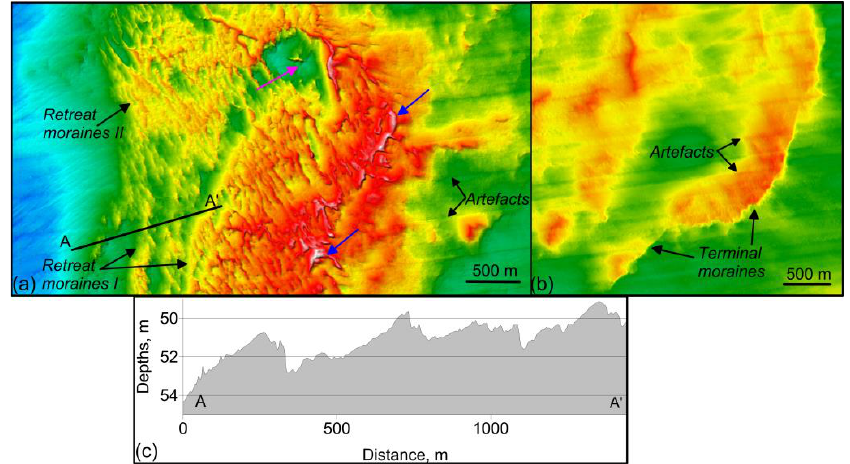
Figure 3. ( a ) Detailed map of the glacial landforms mapped in the north-western part of Area 1; ( b ) Detailed map of the glacial landforms mapped in the south-eastern part of Area 1 (the locations are in Figure 2); ( c ) Bathymetric cross profile through moraines. The location is in Figure 3a. The pink arrow points to the ring structure. Blue arrows indicate possible